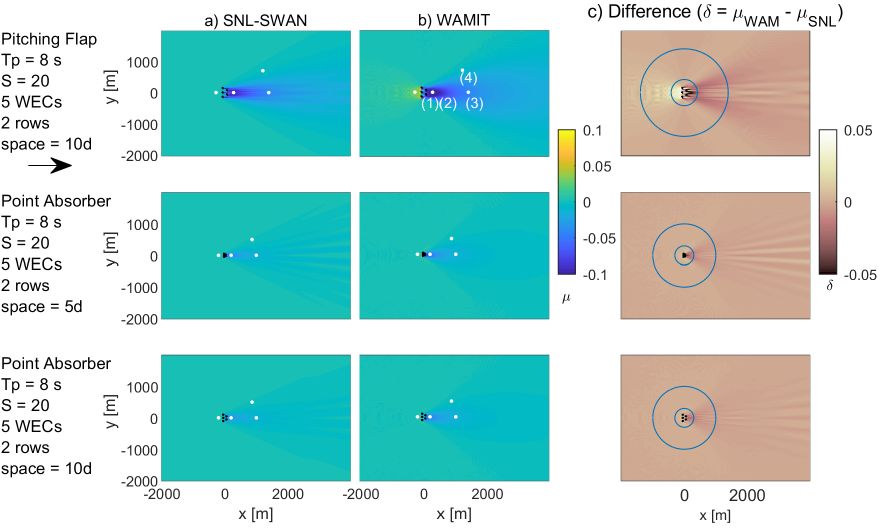
Figure 8. WEC array wave field: ( a ) SNL-SWAN wave field, ( b ) WAMIT wave field, ( c ) difference wave field δ